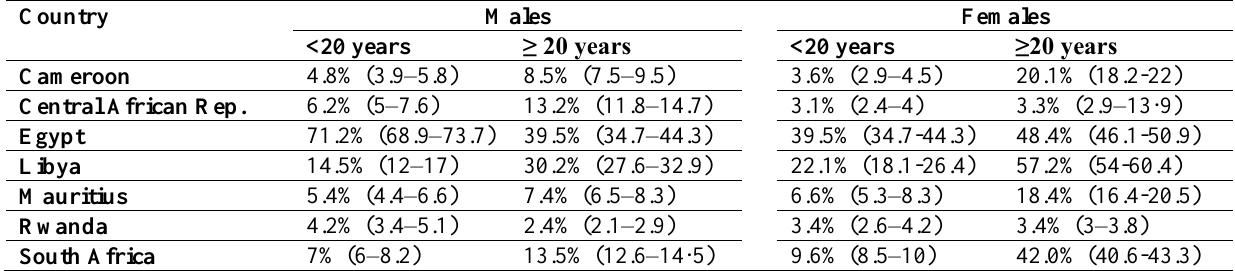
Table 1. Age standardized obesity in some African Countries in 2013 Country Males <20 years ≥ 20 years Central African